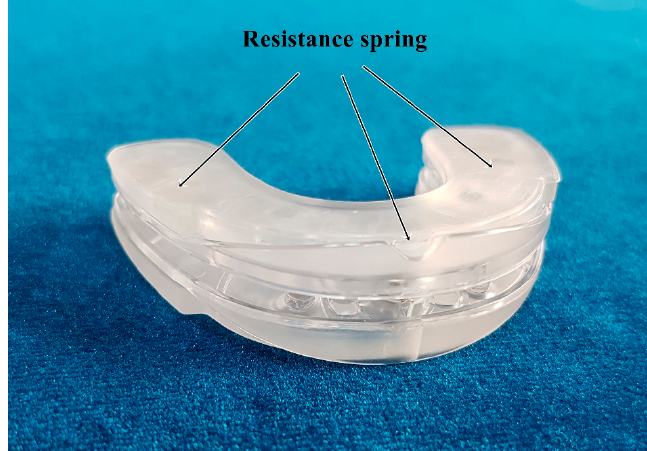
Figure 2. No ‐ Sick Exerciser. Figure 2. No-Sick Exerciser.